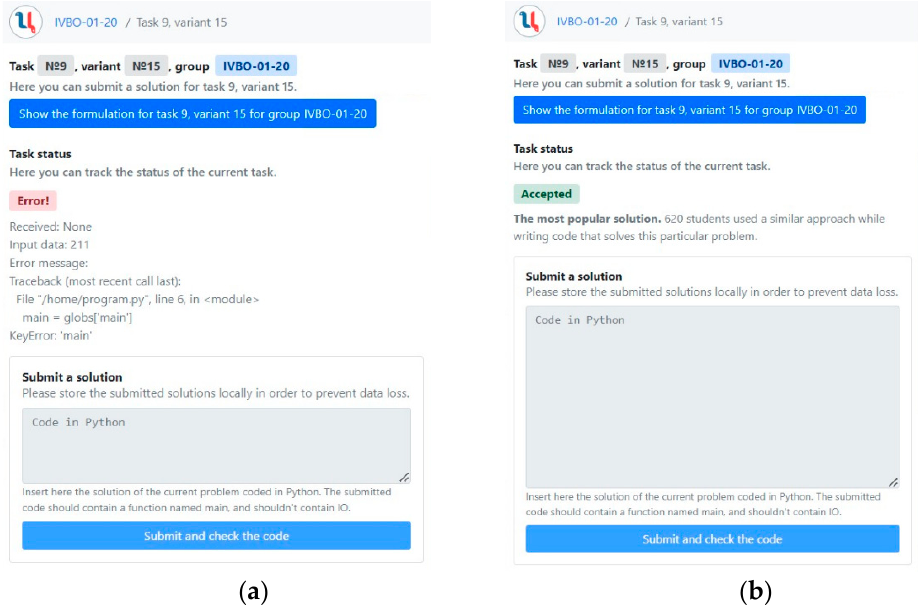
Figure 7. DTA [9,10] web-based UI: ( a ) displaying an error message, ( b ) displaying real-time program text analysis results obtained from ELM fine-tuned with biology-inspired algorithms.